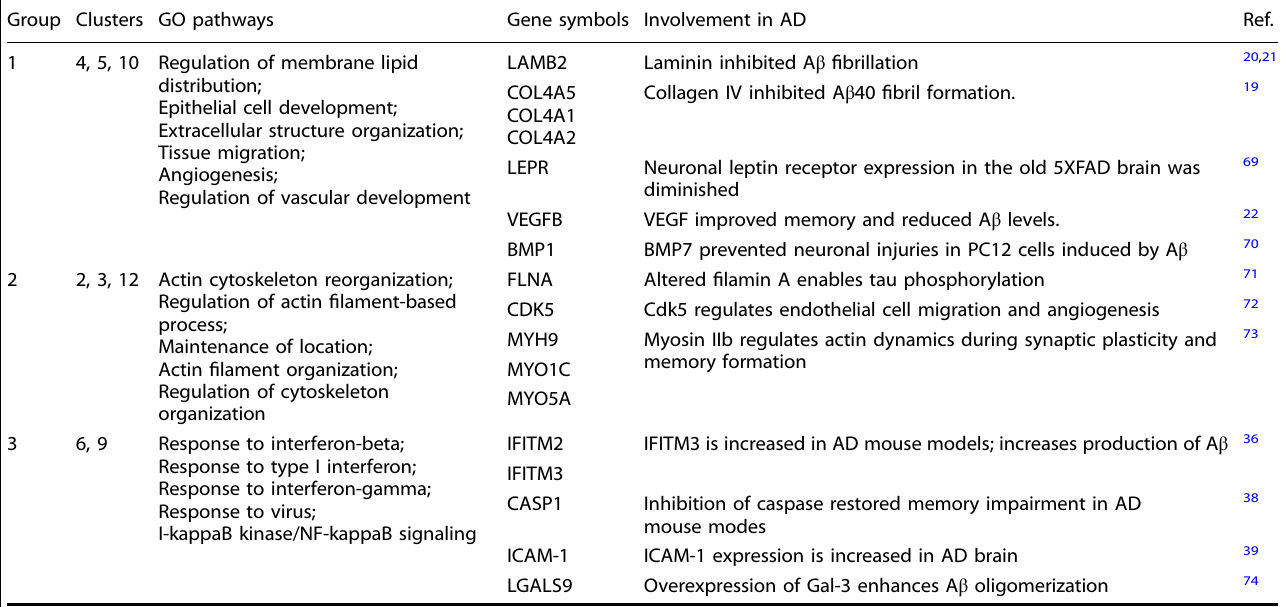
Table 2. GO enrichment analysis of genes in 3 groups and representative genes involved in AD pathology. Group Clusters GO pathways